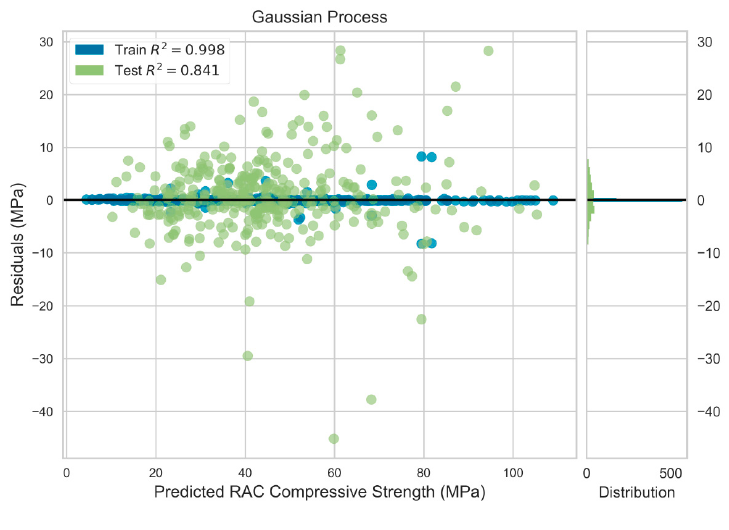
Figure 5. Residuals plot for Gaussian process model.